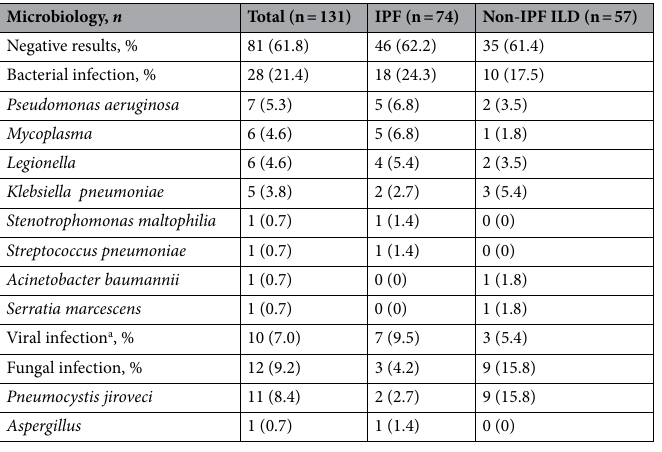
Table 3. Microbiologic results in the triggered AE-ILD group. AE-ILD acute exacerbation of interstitial lung disease. a Metapneumovirus, Influenza virus, Coronavirus, Rhinovirus, and RSV.